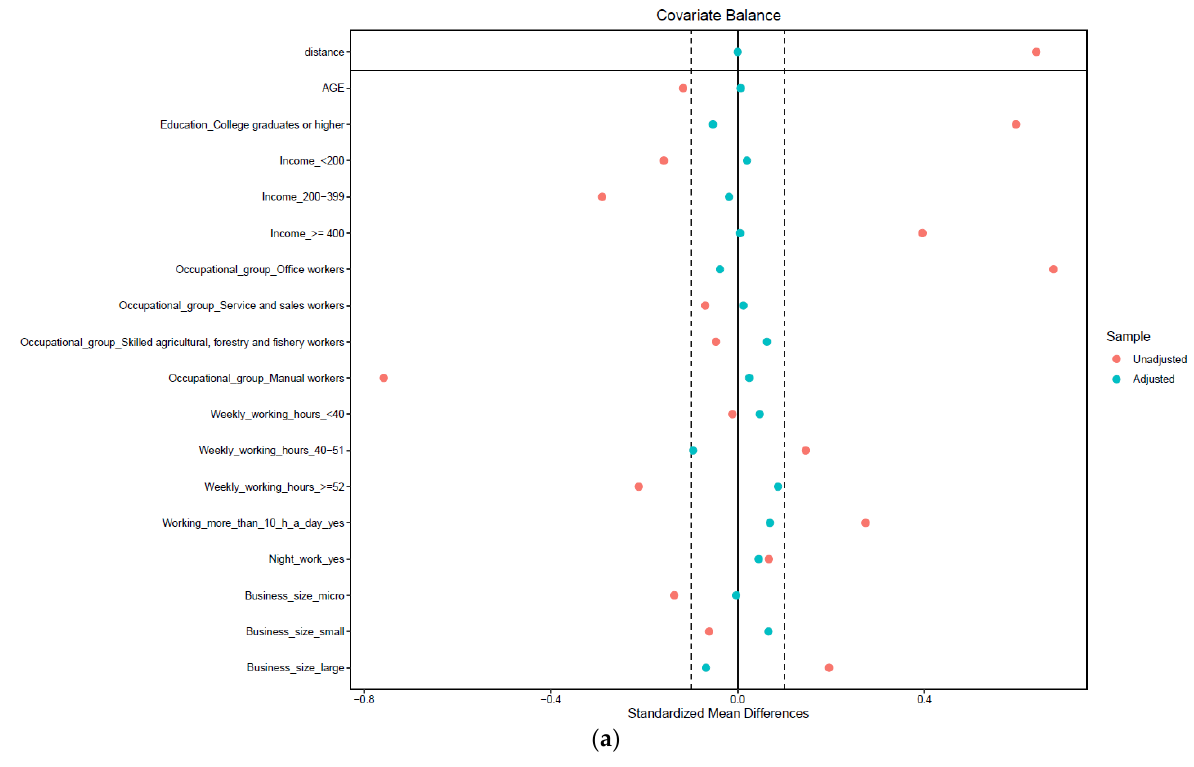
Table 1. Characteristics of male and female participants by telework.